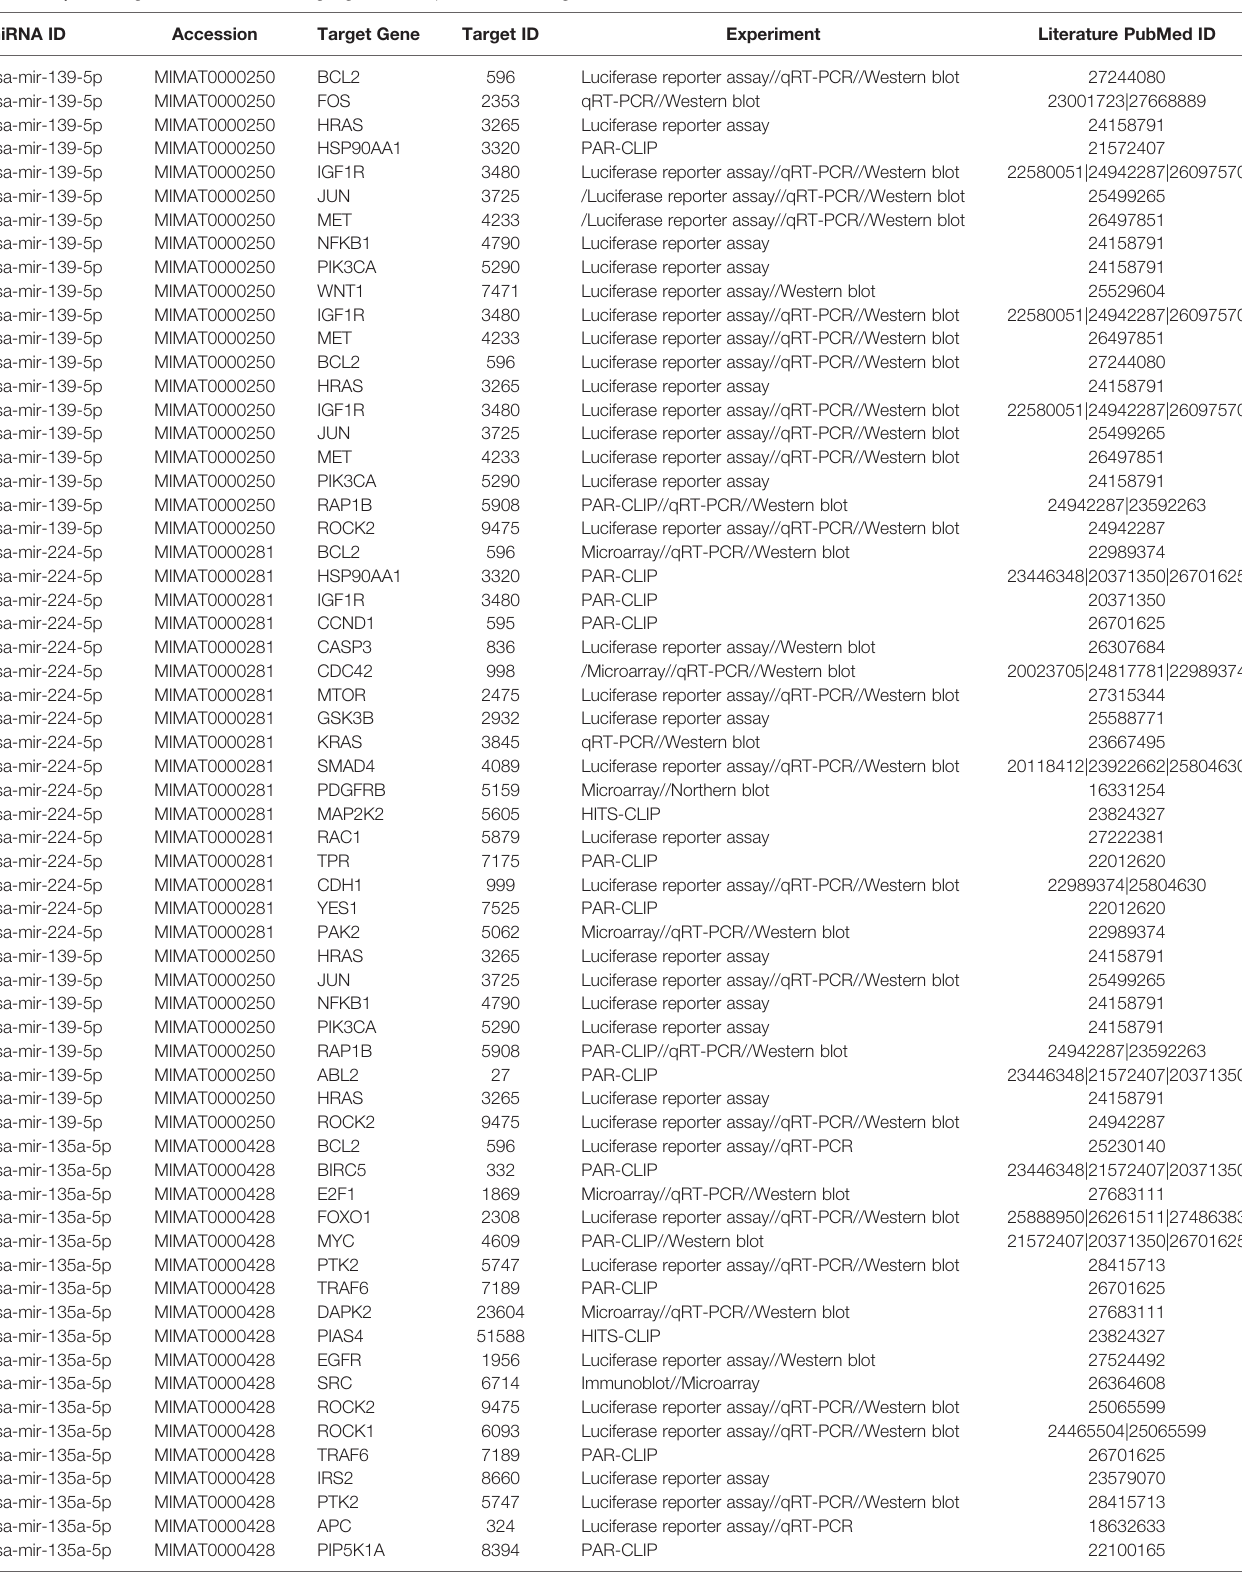
TABLE 4 | Downregulated miRNAS and target genes in response to silencing PGRMC1. miRNA